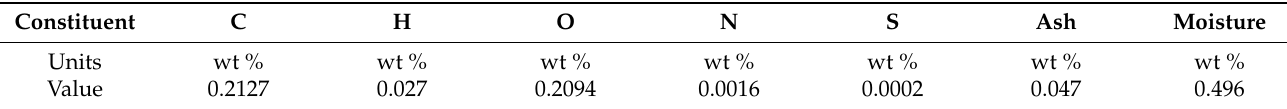
Table 7. Biomass-fired boiler case study model inputs (from site